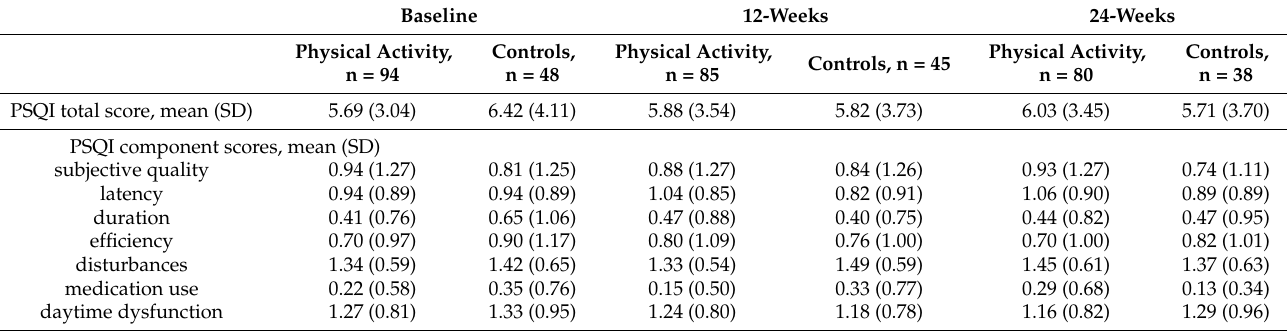
Table 2. Sleep Quality Scores of Older Stroke Survivors